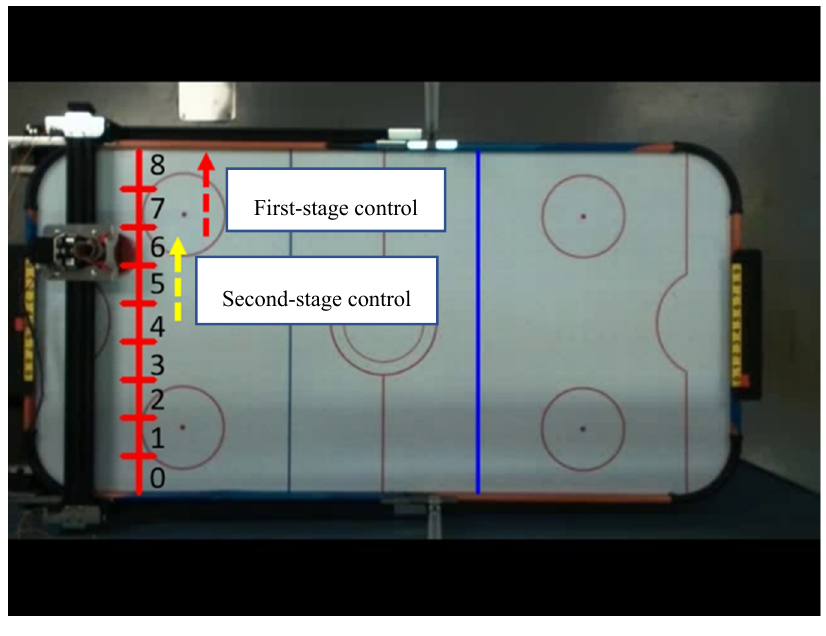
Figure 21. Diagram of the same moving direction.